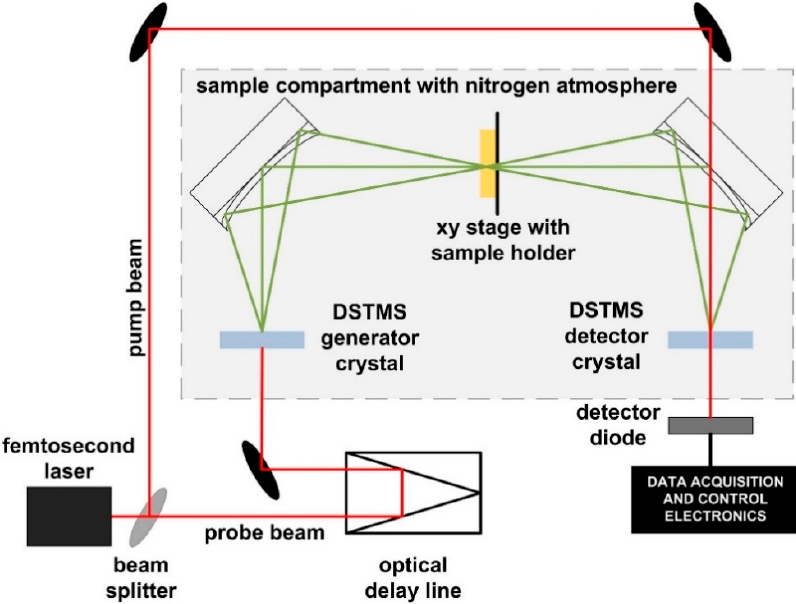
Figure 2. Schematic drawing of the THz spectroscopy and imaging system based on DSTMS organic crystals in transmission geometry.